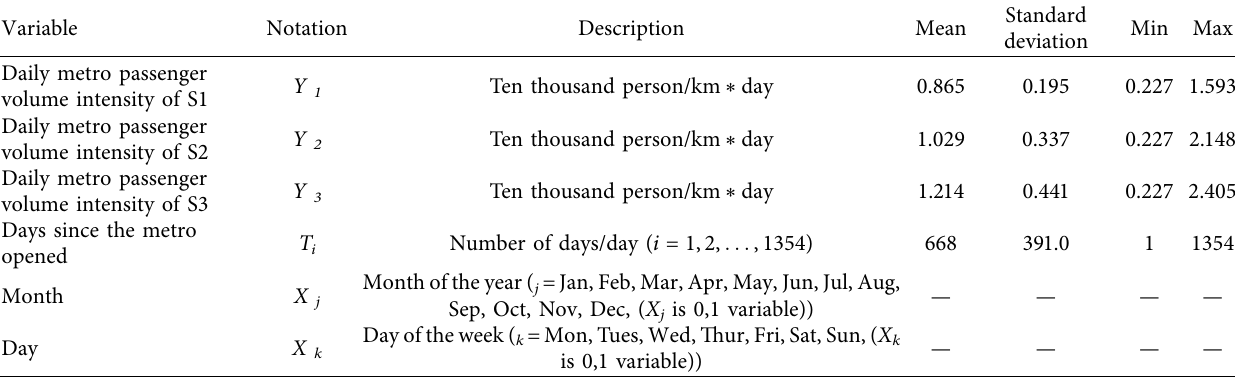
Table 1: Statistic description of dependent and independent